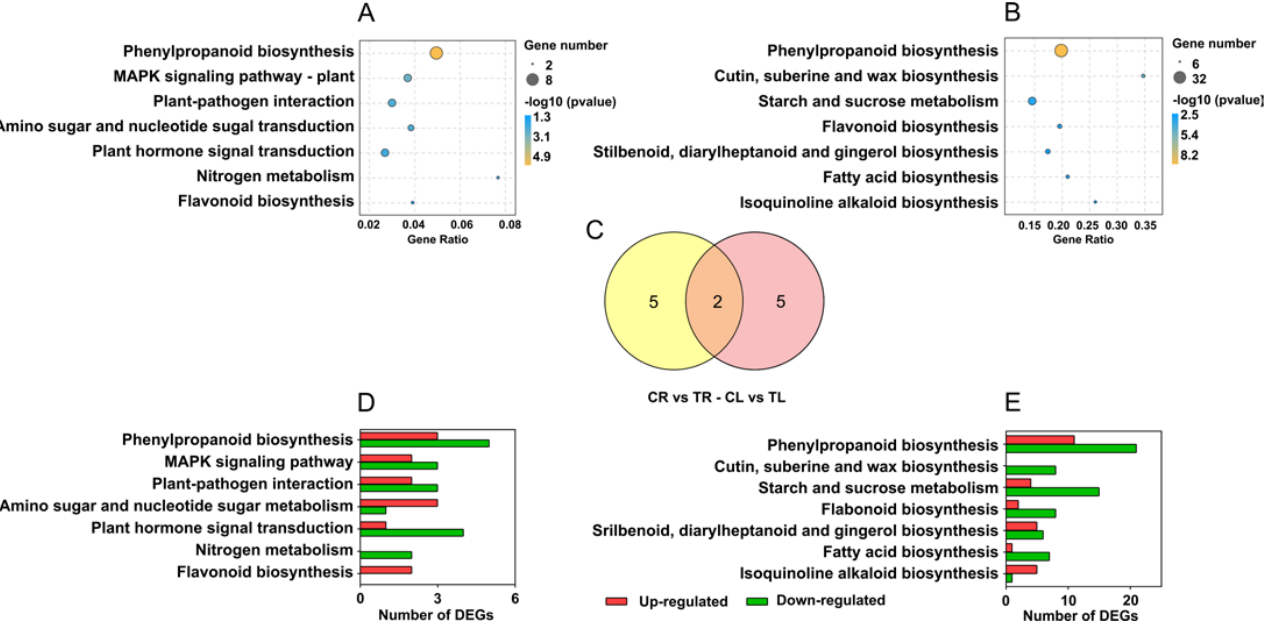
Figure 5. Enriched KEGG pathways of differentially expressed genes (DEGs) in roots and leaves of C. gigantea . ( A ) Enriched KEGG pathways of DEGs in roots. ( B ) Enriched KEGG pathways of DEGs in leaves. ( C ) The number of common and specific enriched KEGG pathways of DEGs in roots and leaves. ( D ) Number of up- and down-regulated genes of the enriched KEGG pathways in roots. ( E ) Number of up- and down-regulated genes of the enriched KEGG pathways in leaves.